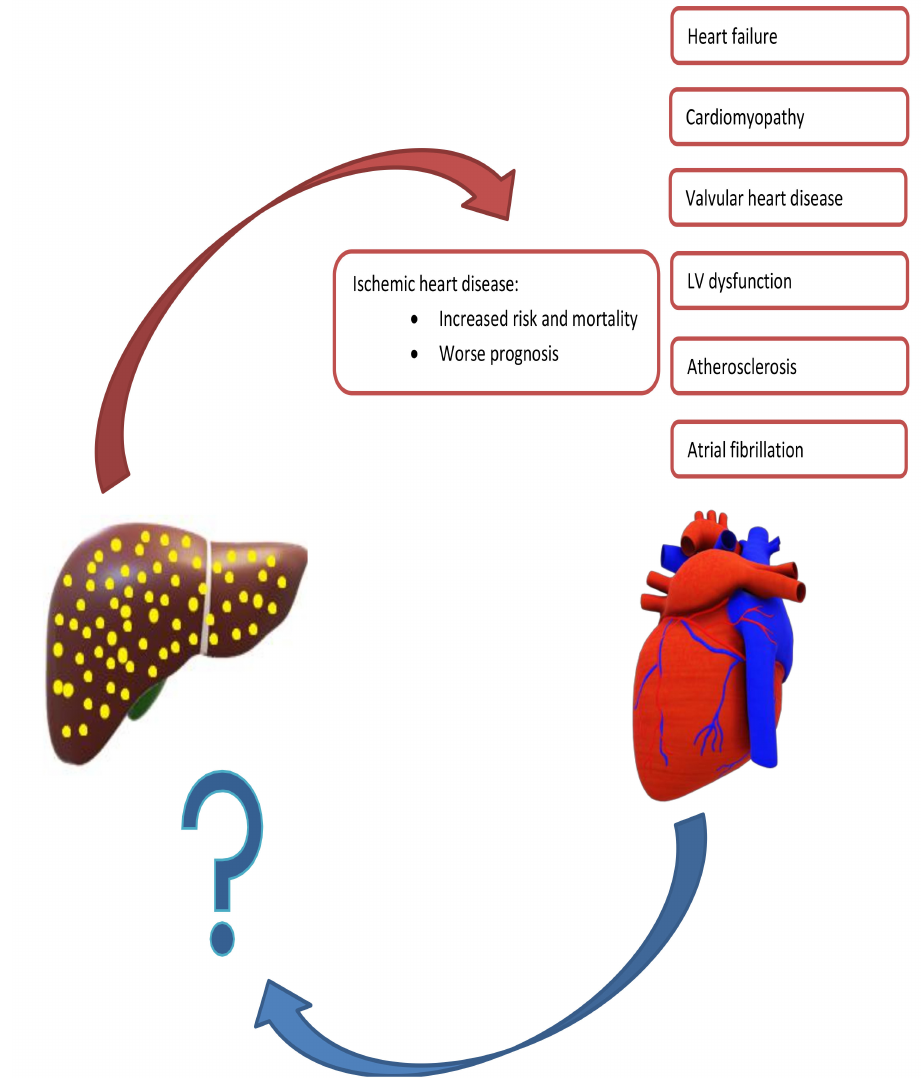
Figure 1. Summary of Mutual Exacerbation of Hepatic and Cardiac Disease Severity. Nonalcoholic fatty liver is associated with several cardiac diseases, including heart failure, cardiomyopathy, ischemic heart disease, and arrythmias. In contrast, there is a paucity of studies evaluating cardiac diseases leading to hepatic